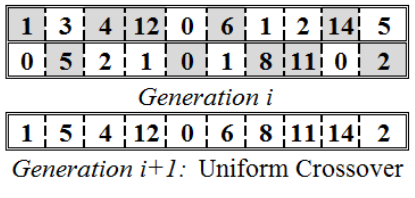
Figure 2. Member encoding representation